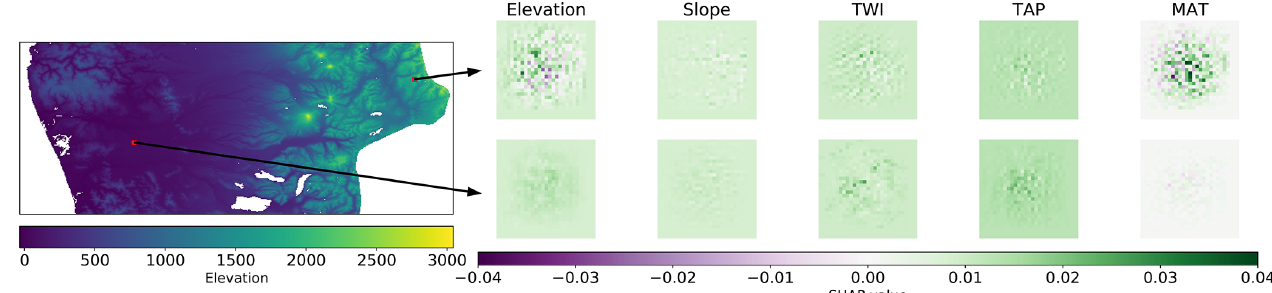
Figure 2. Spatial distribution of SHAP values for each covariate in two different samples (3D arrays used as